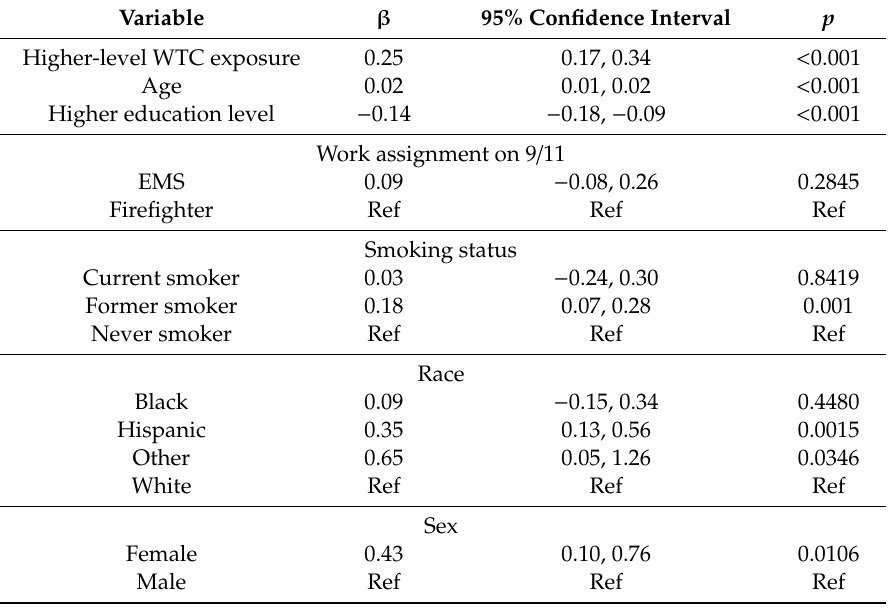
Table 2. Linear regression analysis of World Trade Center (WTC) exposure intensity predicting Cognitive Function Instrument (CFI) score in FDNY rescue / recovery